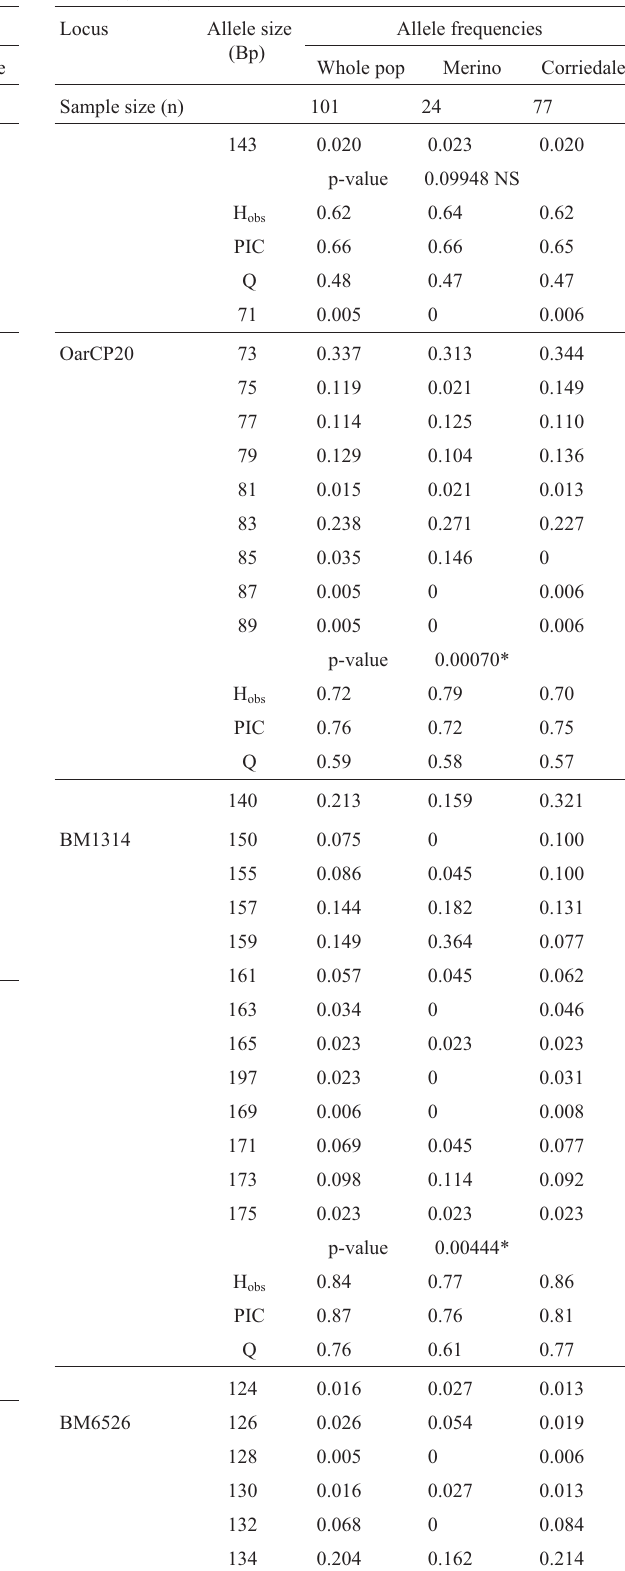
Table I (cont.) Locus Allele size